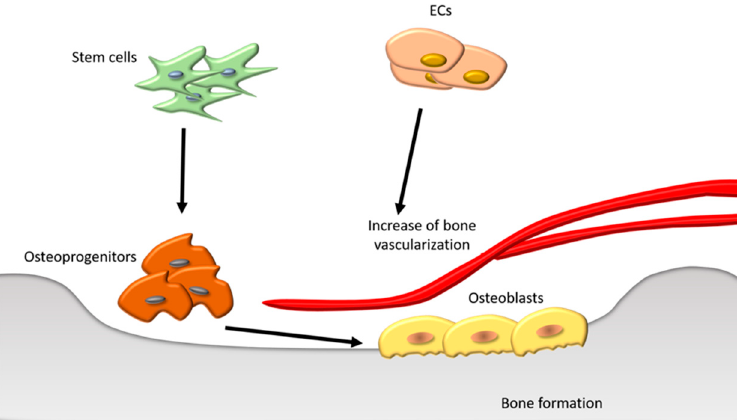
Figure 9. Bone formation: growth factors induce stem cells to differentiate in osteo-progenitors. These cells, in turn, differentiate into osteoblasts that attach to bone. In addition, endothelial cells (ECs) play an important role in the bone formation promoting its vascularization.